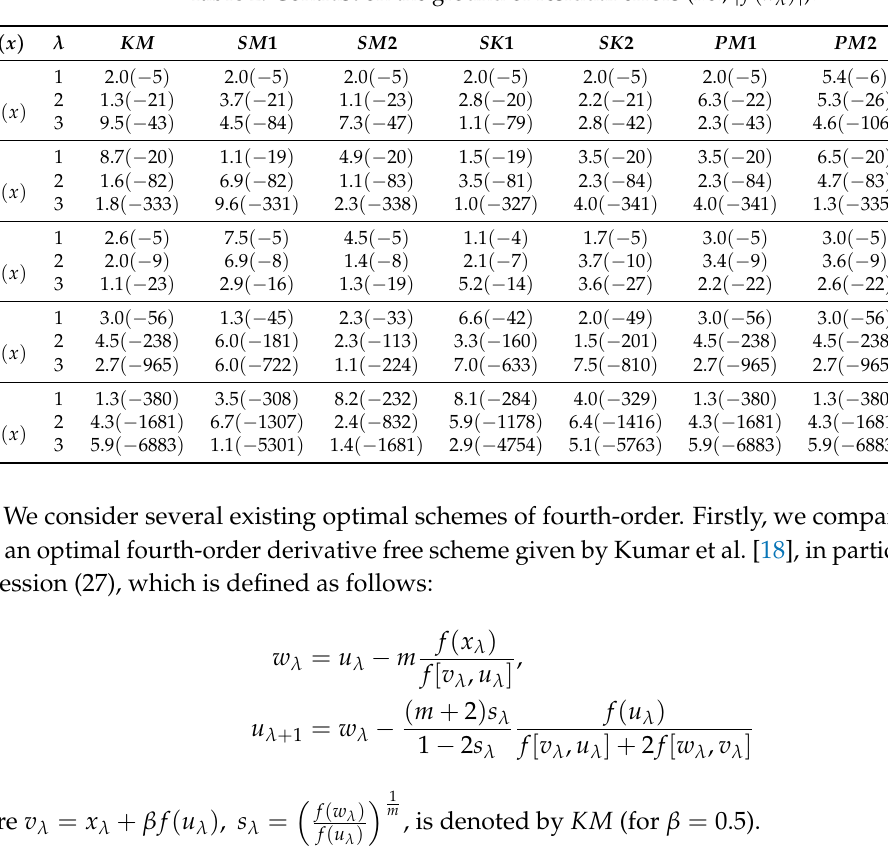
Table 2. Contrast on the ground of residual errors (i.e., | f ( x λ ) |